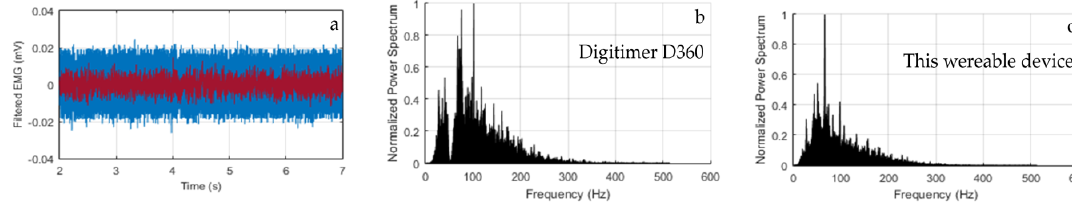
Figure 6. ( a ) Zoom of the baselines of the wearable device (red line) and the Digitimer D360 equipment (blue line); ( b ) FFT of the signals recorded with the Digitimer D360 and ( c ) our wearable device.